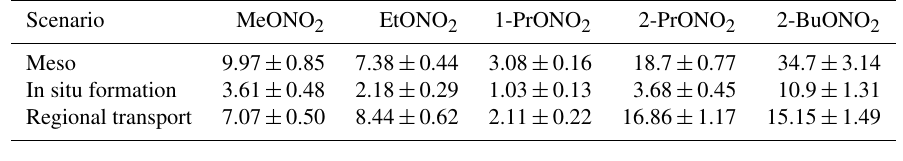
Table 3. Mixing ratios of C 1 –C 4 alkyl nitrates influenced by mesoscale circulation (meso), in situ formation and regional transport at TMS (unit: pptv).